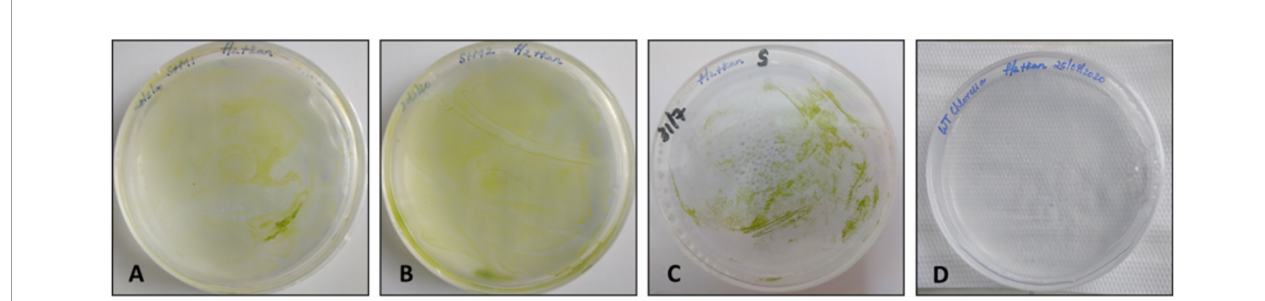
FIGURE 2 | Chloroplast-transformed Chlorella vulgaris cells by electroporation with sorbitol – mannitol and sorbitol buffers plated on f/2 agar plates with 50 mg/L kanamycin. (A) SM-L transformed cells, (B) SM-NL transformed cells, (C) S-L transformed cells in colony 1, and (D) wild-type C. vulgaris cells on antibiotic selection plate.